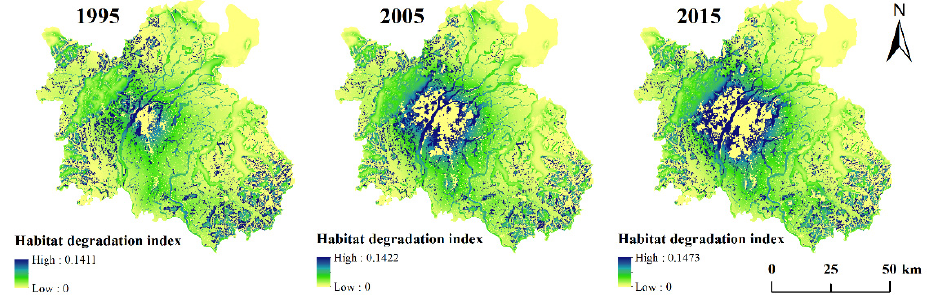
Figure 4. Spatial distribution pattern of the habitat degradation index in 1995, 2005, and 2015.